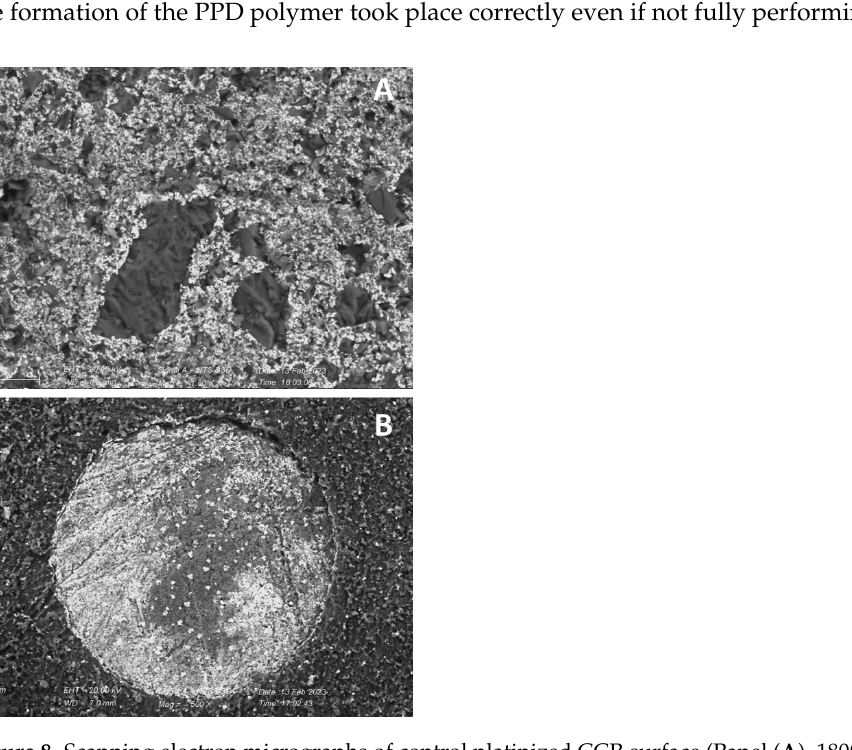
Figure 8. Scanning electron micrographs of control platinized CCR surface (Panel ( A ), 1800 × magnification) and platinized PL surface (Panel ( B ), 500 × magnification).